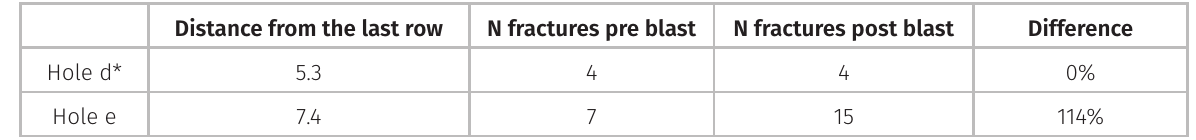
Table IX. Fracturing intensity pre and post blast test